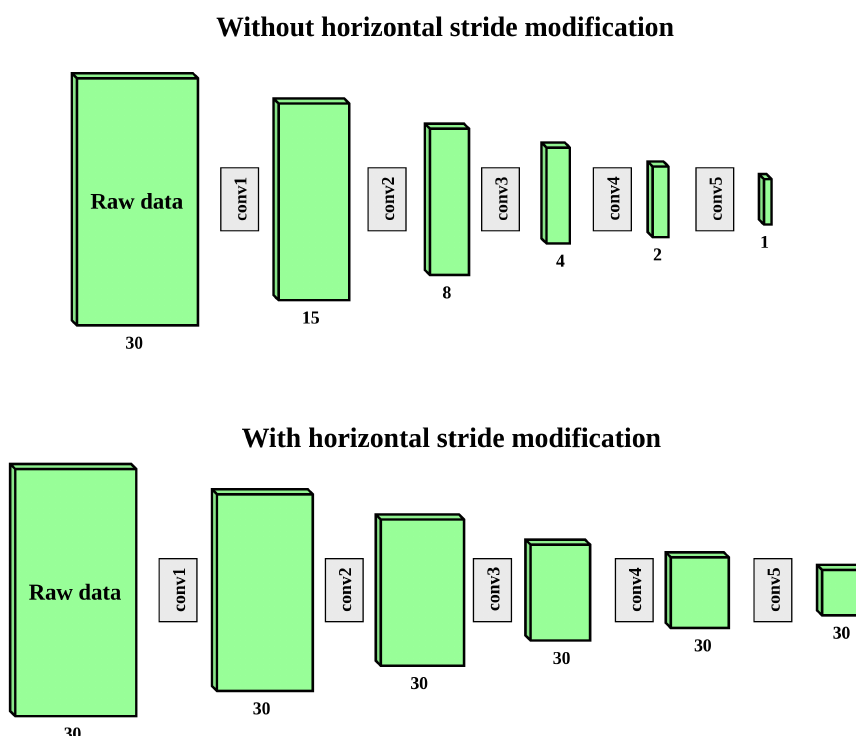
Figure 10. The spatial dimensions of the input raw data matrix and subsequent subsampled interme- diate representations after each group of convolutional layers. For groups conv1, conv3, conv4, and conv5, the subsampling is completed in the first convolutional layer of the group. For group conv2, the subsampling is completed in the max pooling layer immediately before the first convolutional layer of conv2. The first diagram show how, without any modification to the ResNet18 architecture, both the vertical and horizontal dimensions are halved five times. The vertical dimension is down- sampled from 1024 to 32, while the horizontal dimension is downsampled from 30 to 1. The second diagram shows how only the vertical dimension is subsampled after our modification to the ResNet18 architecture, while the horizontal dimension remains constant. This is because our modification sets the horizontal stride of subsampling layers to 1. Note that the dimensions in the figure are not to scale due to impracticality of displaying very tall and narrow